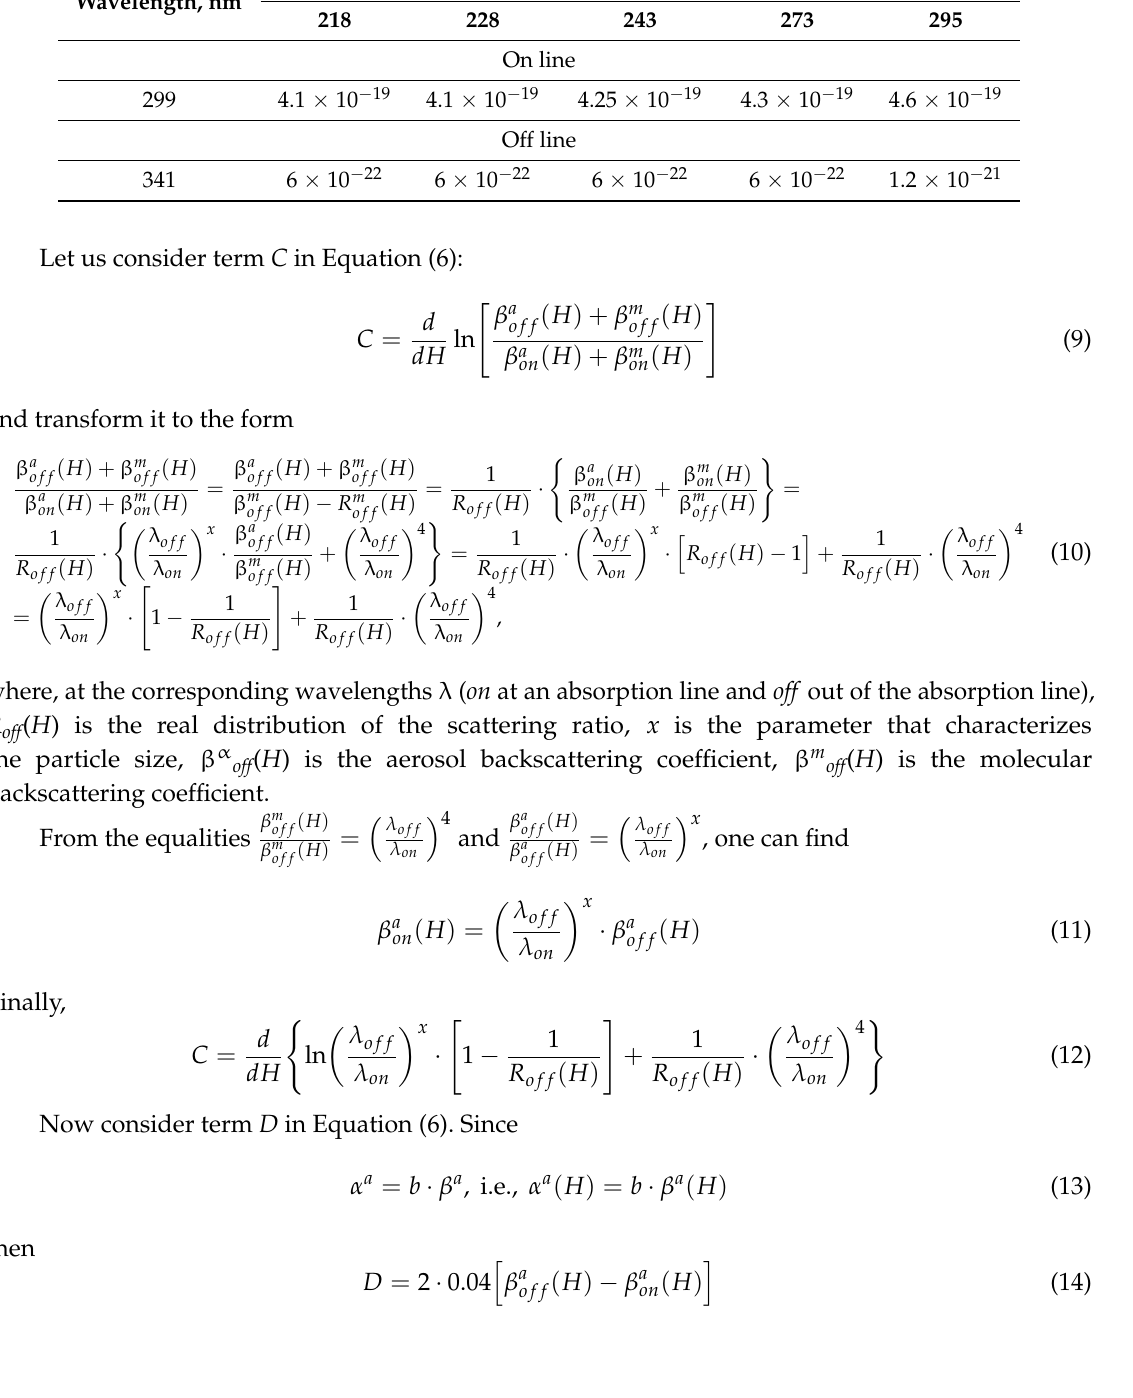
Table 3. Ozone absorption cross-section (cm 2 ) at the ozone sounding wavelengths [18,19]. Wavelength, nm